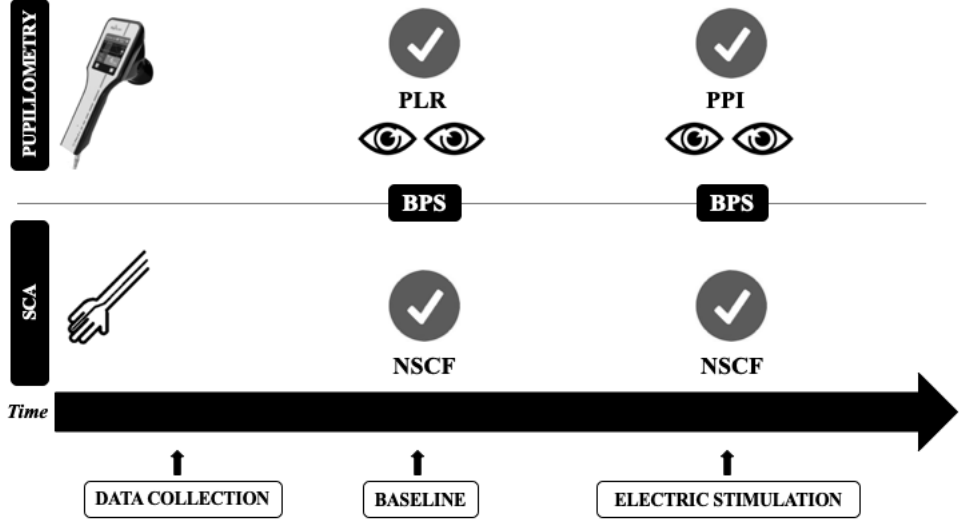
Figure 1. Timeline of the study protocol. PLR = pupillary light reflex; PPI = pupil pain index; NSCF = number of skin conductance fluctuations; BPS = behavioral pain scale; SCA = skin conductance algesimeter.